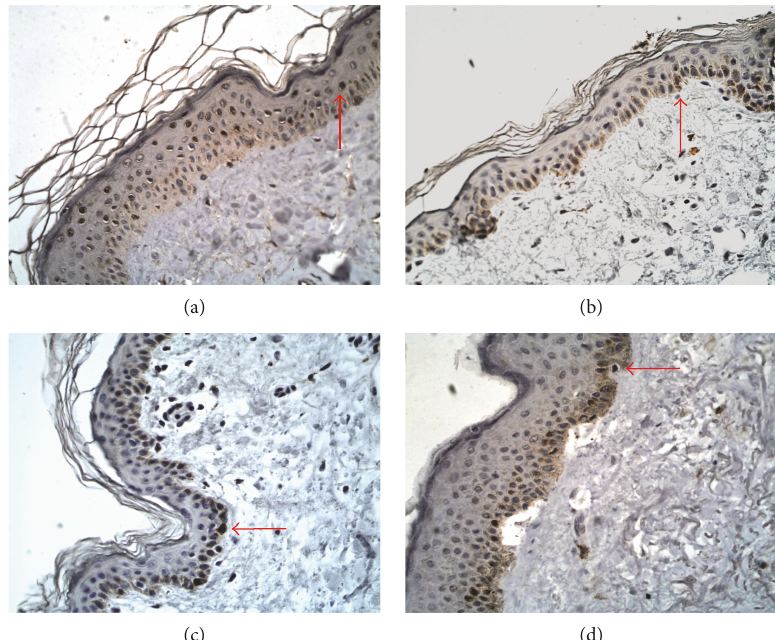
Figure 5: Immunoexpression of JAK/STAT proteins in epidermis, normal skin, 400x, immunohistochemistry. (a) Immunoexpression of JAK3 in epidermis, normal skin, 10.73 ± 3.36. (b) Immunoexpression of STAT2 in epidermis, normal skin, 11.06 ± 5.34. (c) Immunoexpression of STAT4 in epidermis, normal skin, 18.59 ± 3.01. (d) Immunoexpression of STAT6 in epidermis, normal skin, 11.56 ±